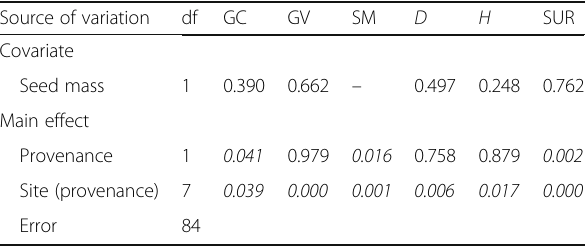
Table 2 Significance level of the provenance, the intra-provenance and the covariate effects (seed mass) on the variance of germination, growth and survival traits measured in Nothofagus glauca Source of variation df